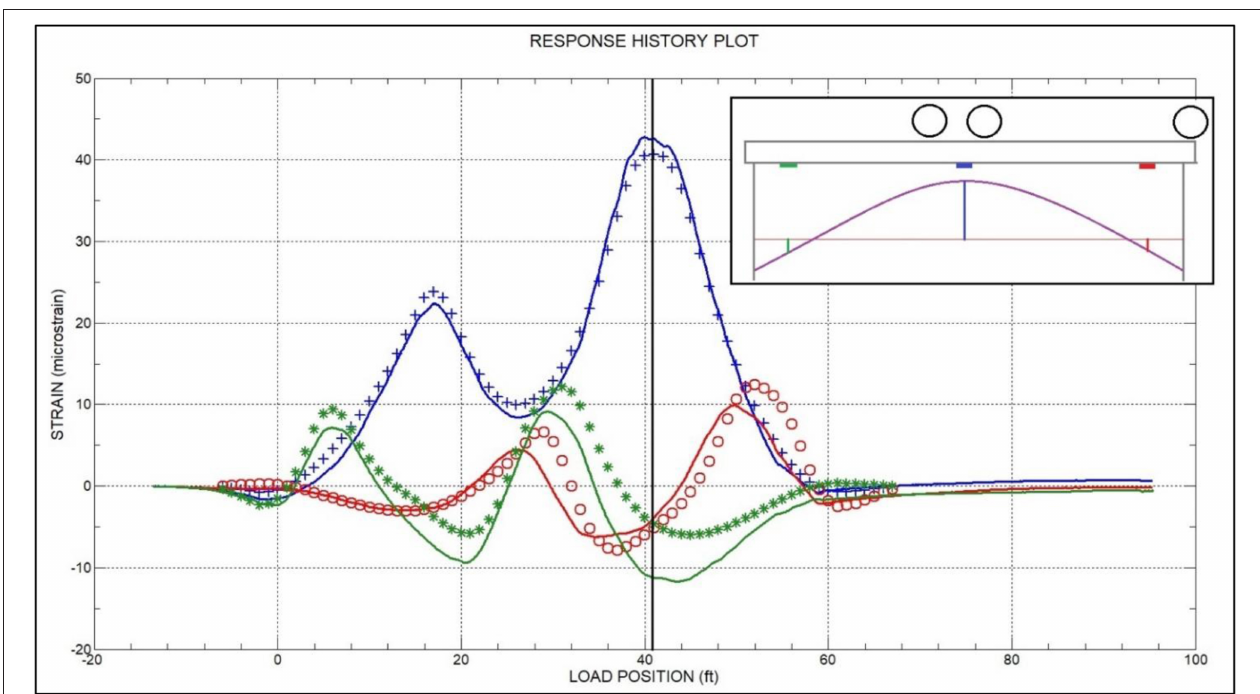
FIGURE 4 | Measured and computed strain histories at three locations on a single